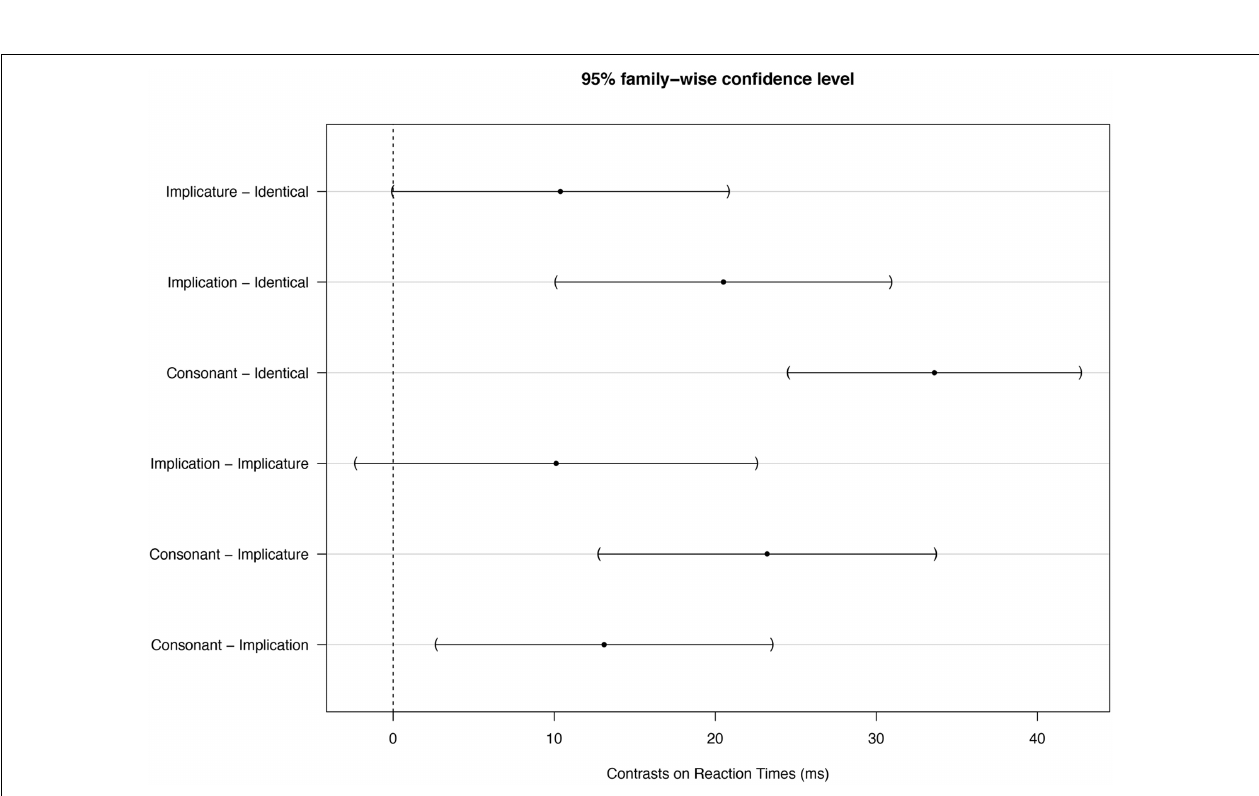
FIGURE 3 | Confidence intervals obtained with a 95% family wise estimate for Tukey contrasts on condition with our linear mixed effect model.